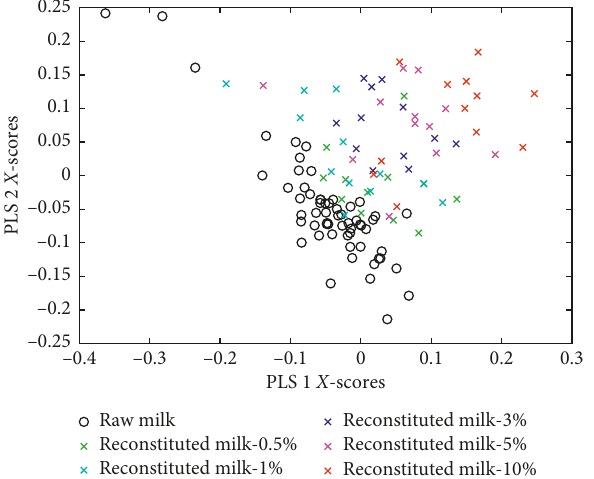
Figure 4: Partial least-squares-discriminant analysis (PLS-DA) scores plot of FTIR fingerprints.